Question: Summarize what this figure shows in one sentence.
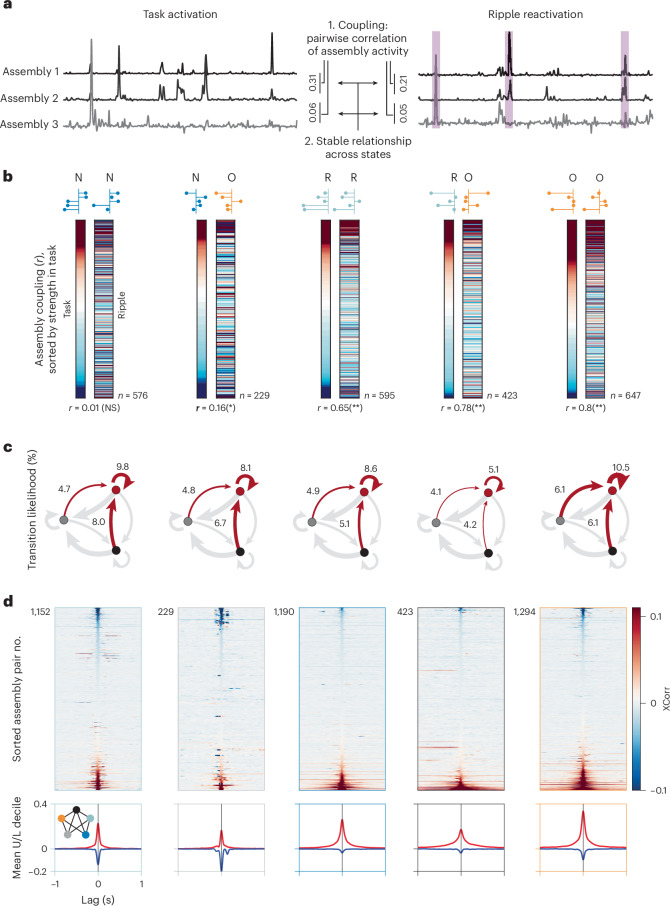
Answer: Changes in assembly coupling with memory age. a , Assembly coupling 1 was calculated as the pairwise correlation of activation strengths for each assembly pair during the task and again during ripples. Shown are the coupling values obtained from three assemblies (two pairs: 1 and 2, and 2 and 3) during the task and separately during ripples. Across all pairs within a given age category, the consistency of coupling 2 between task and sleep was measured using a Pearson correlation. Purple shading indicates time windows corresponding to detected ripples. b , Color-coded plots of coupling strength (coactivation or coreactivation) between pairs of cell assemblies across different memory categories during task events and sleep ripple events. Pairs were sorted based on task activation coupling strength. The consistency of coupling across task and ripple epochs was quantified as the Pearson’s correlation, shown below each plot (* P < 0.05, ** P < 0.01). c , Average Markov state transition likelihoods between assemblies. Transition states are activation (red), baseline (gray) and suppression (black). Only transitions to the active state are shown, with arrow thickness indicating greater transition probabilities. Note that the other transitions are depicted schematically and are identical across plots. See Methods and Extended Data Fig. 6 for the full transition table. d , Top: assembly cross-correlograms for pairs of each memory type, sorted by strength at 0 lag. Bottom: averages of the first (upper, red) and last (lower, blue) deciles of the sorted responses. The inset shows differences in the full-width at half-maximum lags of these groups ( P < 0.01; permutation test with FDR correction), organized in descending order of the longest lags. Both magnitude and longevity of coactivations vary across groups and show similar patterns to the Markov state transitions. NS, nonsignificant; U/L upper, lower.